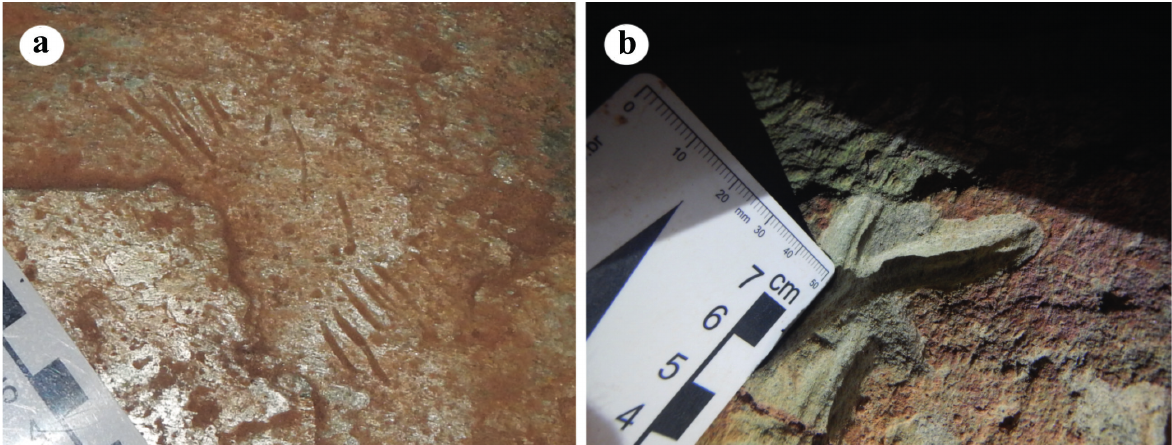
Figure 5 - Traces produced in diff erent substrates within the cave. ( a ) hematite and ( b ) siliceous